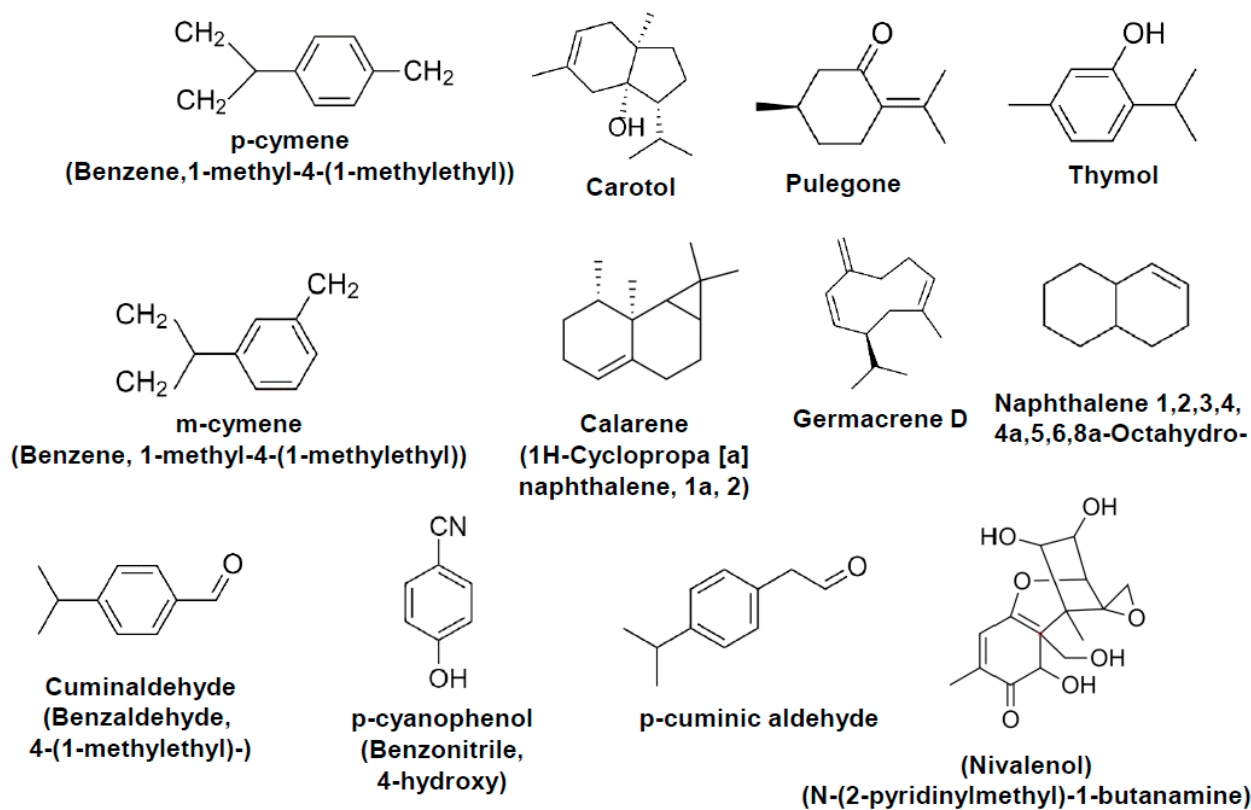
Figure 7. Chemical structure of phytocompounds identified in cumin. Ethanolic cumin extract was dissolved in methanol and analyzed by GC-MS to identify the chemical constituents on a GCD 1800A Hewlett Packard apparatus coupled with a HP-1 column. Helium was used as a carrier gas at the rate of 1 mL/min. Identification of major compounds was carried out on the basis of exact mass and compared with MS reference database of NBS75K.